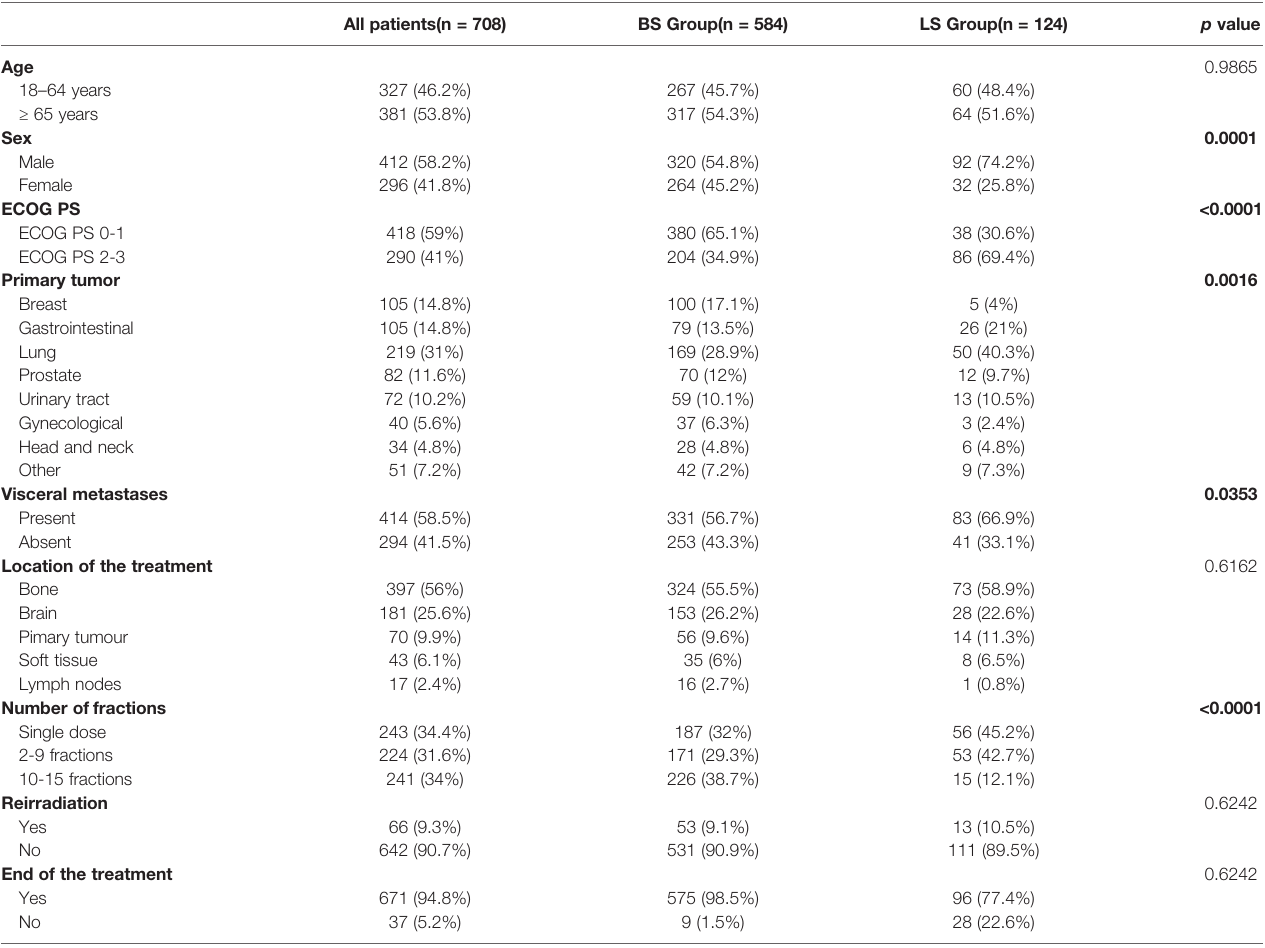
TABLE 1 | Sample characteristics and descriptive analysis according to the state at